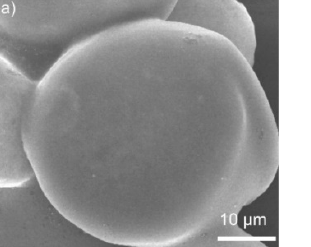
Figure 5. ( a ) SEM and ( b – d ) mapping images of the Co 3 O 4 -infilled microcapsules. ( e ) Related EDS